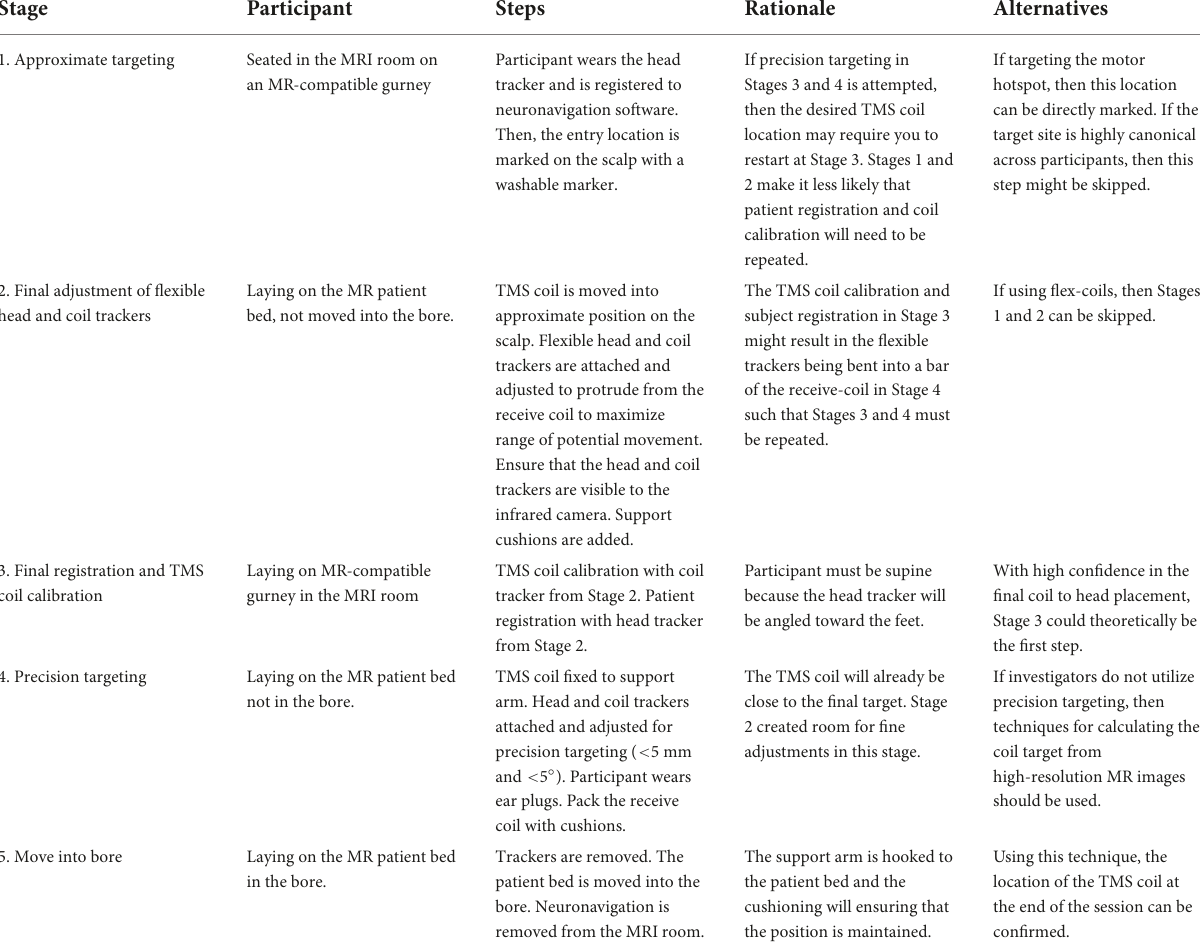
TABLE 1 Neuronavigation in the MRI room for precision